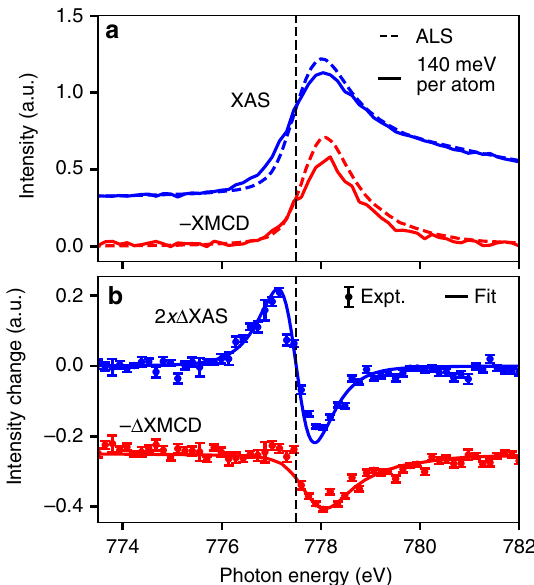
Fig. 3 Dependence of X-ray absorption on deposited X-ray energy. This fi gure shows spectra recorded with 140 meV/atom pulse averaged X-ray energy absorbed in the Co/Pd multilayer (280 meV/atom total absorbed energy, 16 mJ/cm 2 total absorbed fl uence) and those recorded on the same sample in the low fl uence limit at the Advanced Light Source (ALS) synchrotron light source. a XAS and XMCD. b Changes in XAS and XMCD relative to the low fl uence limit. The XAS change is fi t to that expected for an electronic temperature change described by a Fermi-Dirac distribution with a constant density of states near the Fermi level, while the XMCD change is fi t to a uniform reduction in XMCD. The vertical error bars show the standard error of the displayed quantities. Each combination of photon energy and sample magnetization direction had a median of 11 measurements with different X-ray pulses. Source data provided as a Source Data fi